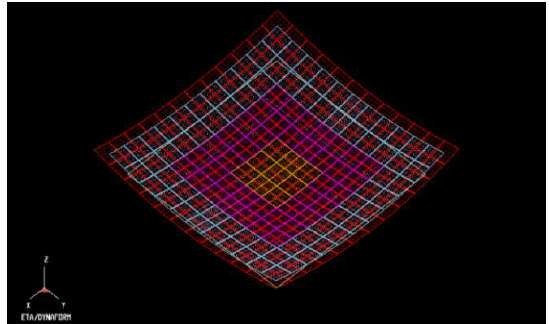
Figure 3. Preprocessing model.